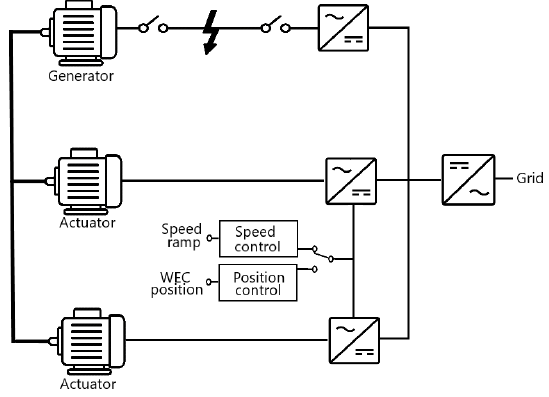
Fig. 7. Control scheme with a fault occurring between EMU (generator) and its power